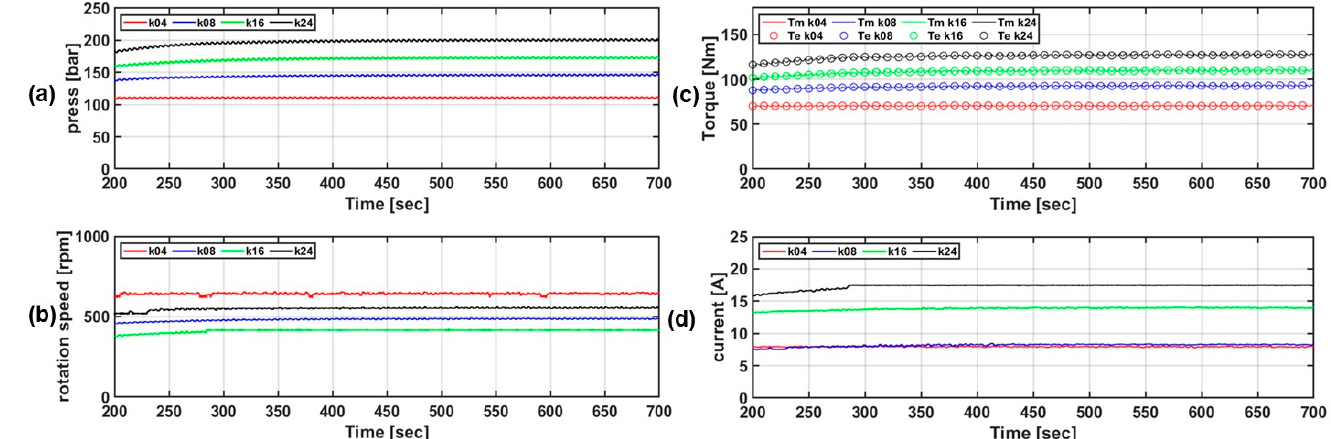
Figure 14. ( a ) Circuit pressure, ( b ) hydraulic motor rpm, ( c ) mechanical and electrical torques, and ( d ) load current according to the torque coefficient of the optimal torque control algorithm under regular wave conditions (legends indicate torque coefficients).